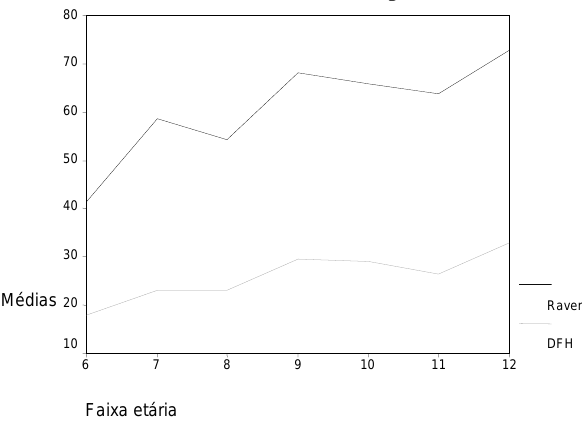
Figura 1. Médias no DFH e no Raven por faixa etária Pode-se pensar que o construto avaliado pelo DFH apro- xime-se mais daquele avaliado pelo Raven do que da faceta da inteligência avaliada através do TNVRI. Embora tanto o Raven quanto o TNVRI proponham-se a avaliar raciocinio